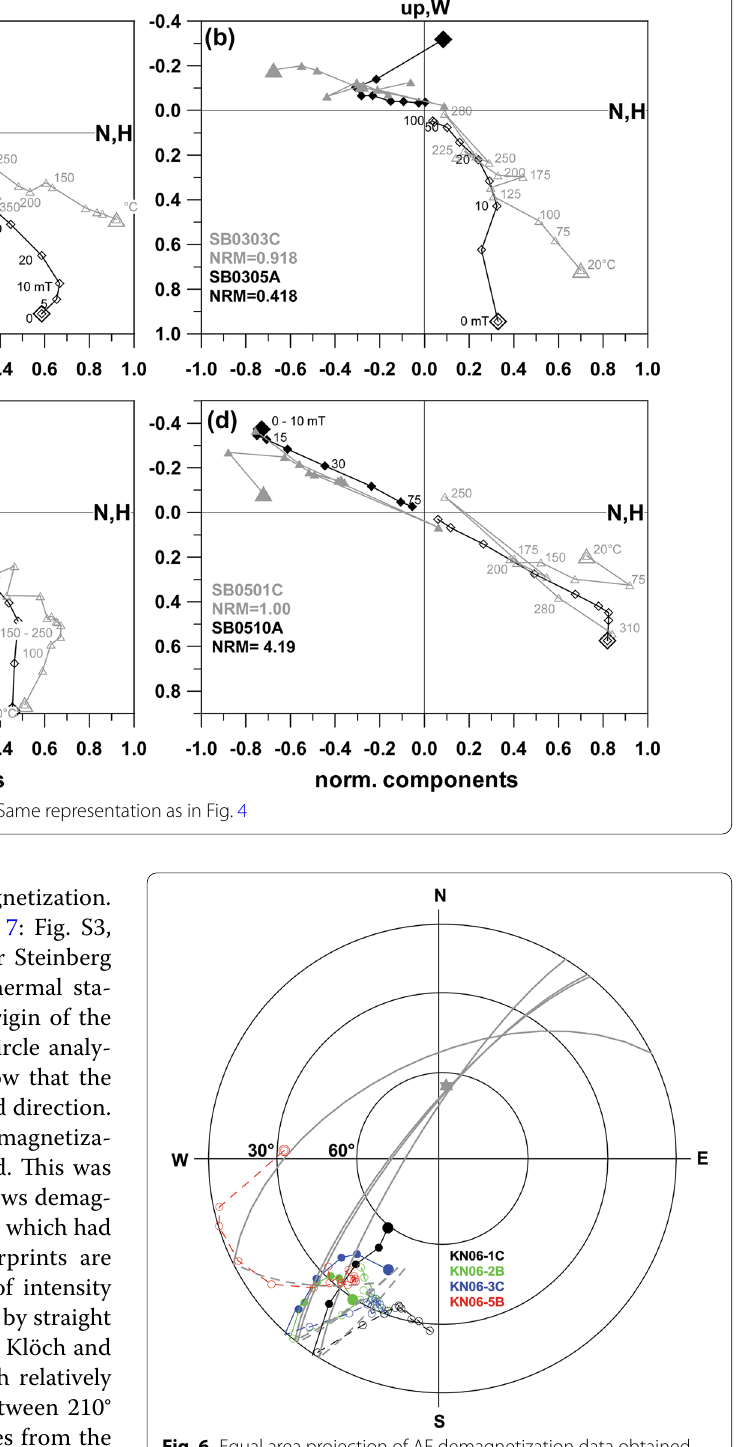
Fig. 6 Equal area projection of AF demagnetization data obtained from Klöch. Open symbols represent negative inclinations, closed symbols positive. The NRM is indicated by a larger symbol. Great circles fitted to the secondary component are shown in gray. The gray star gives the present field